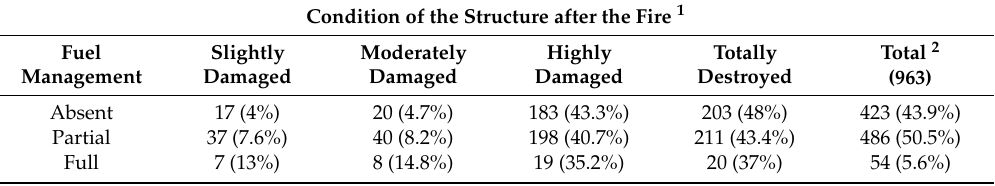
Table 8. Degree of damage according to the fuel management on the surroundings of the structure.